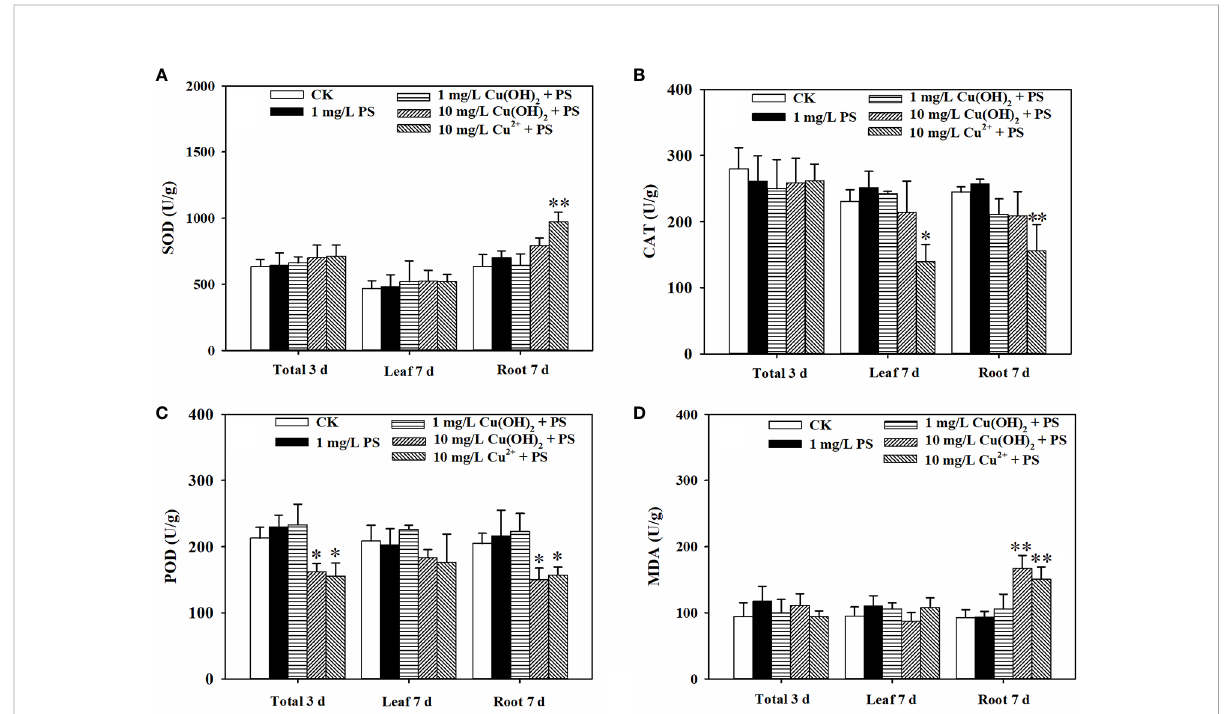
FIGURE 5 Effect of 1 mg/L PS MPs with or without Cu(OH) 2 nanowire or Cu 2+ stress on the activities of SOD (A) , CAT (B) and POD (C) and the MDA levels (D) in lettuce seeds (3d) and in lettuce seedling leaves and roots (7d). The data were from four replicates and were analyzed with a t test to explore any signi fi cant differences between treatment groups; the asterisks * ( p < 0.05) and ** ( p < 0.01) denote statistical signi fi cance and high statistical signi fi cance,